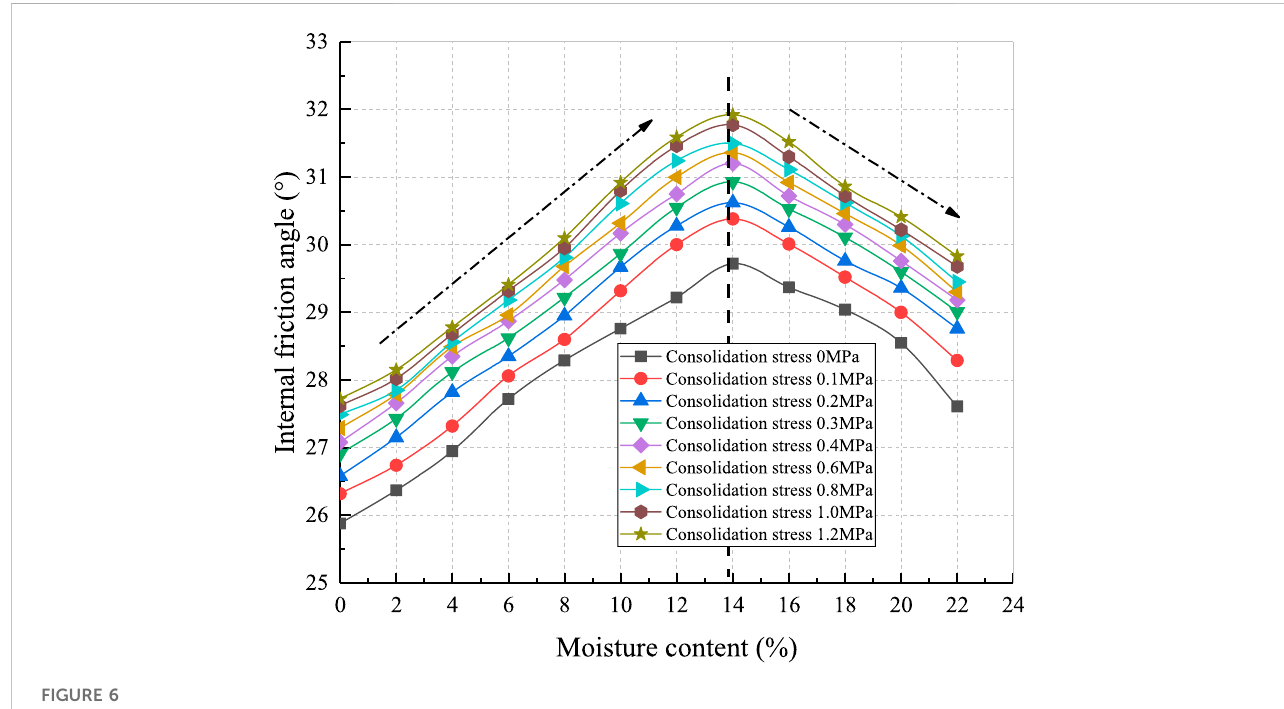
FIGURE 6 Relationship between internal friction angle and moisture content.